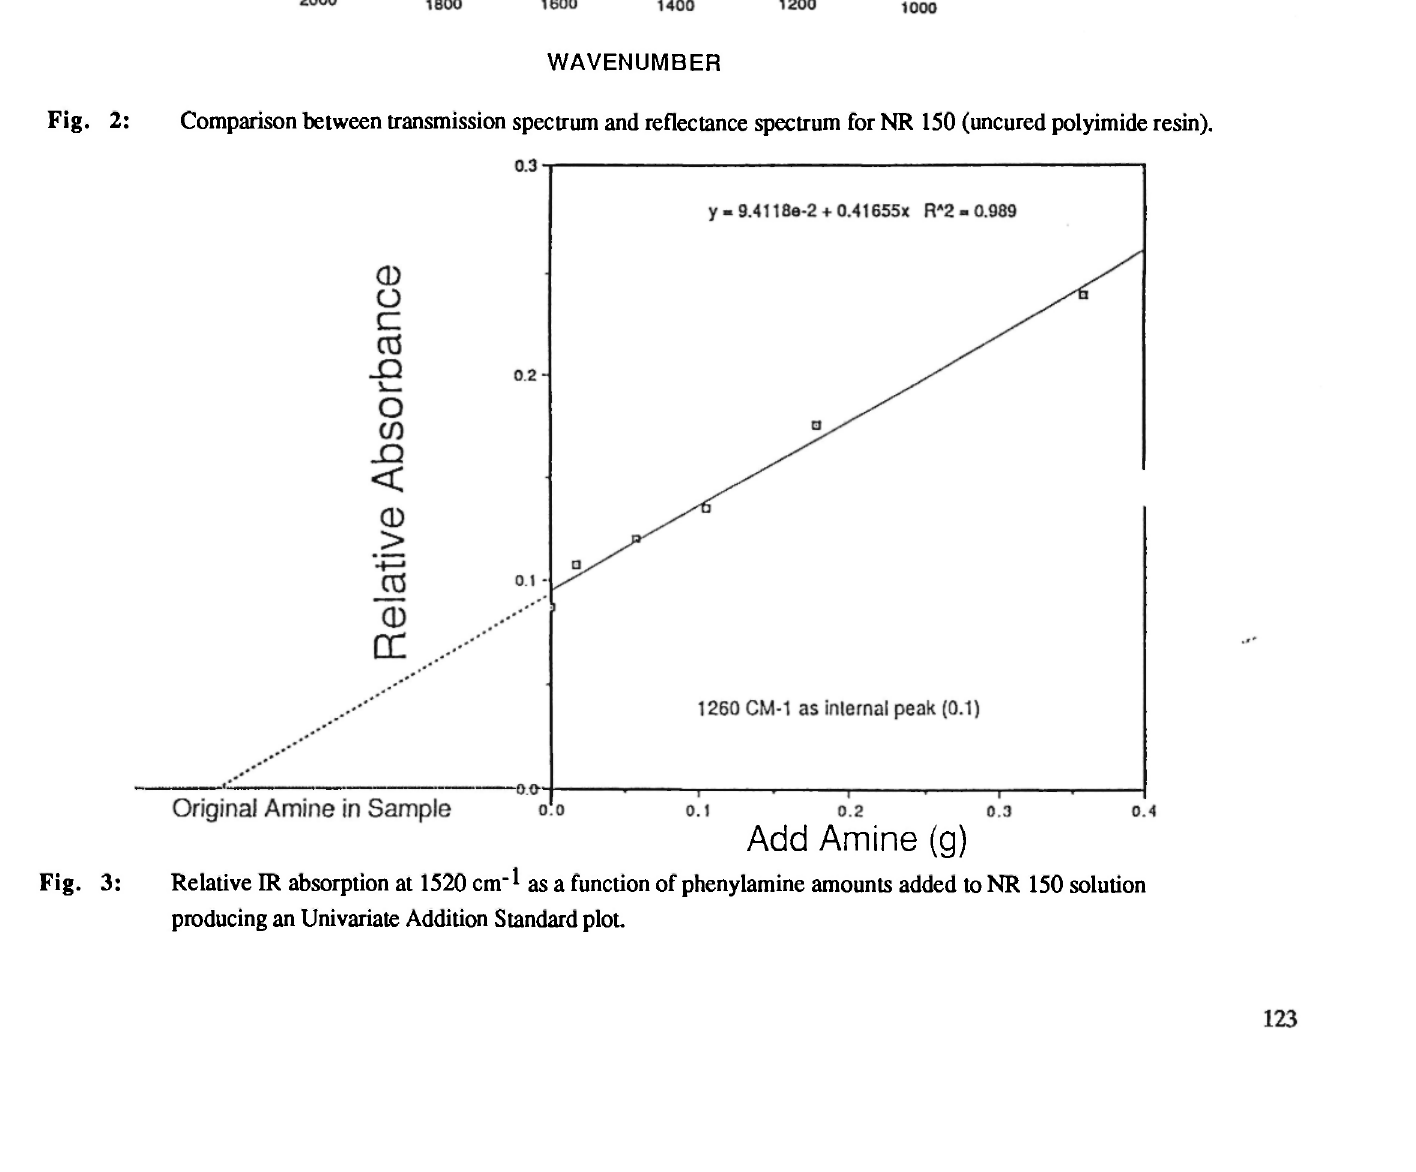
Fig. 3: Relative IR absorption at 1520 cm -1 as a function of phenylamine amounts added to NR 150 solution producing an Univariate Addition Standard